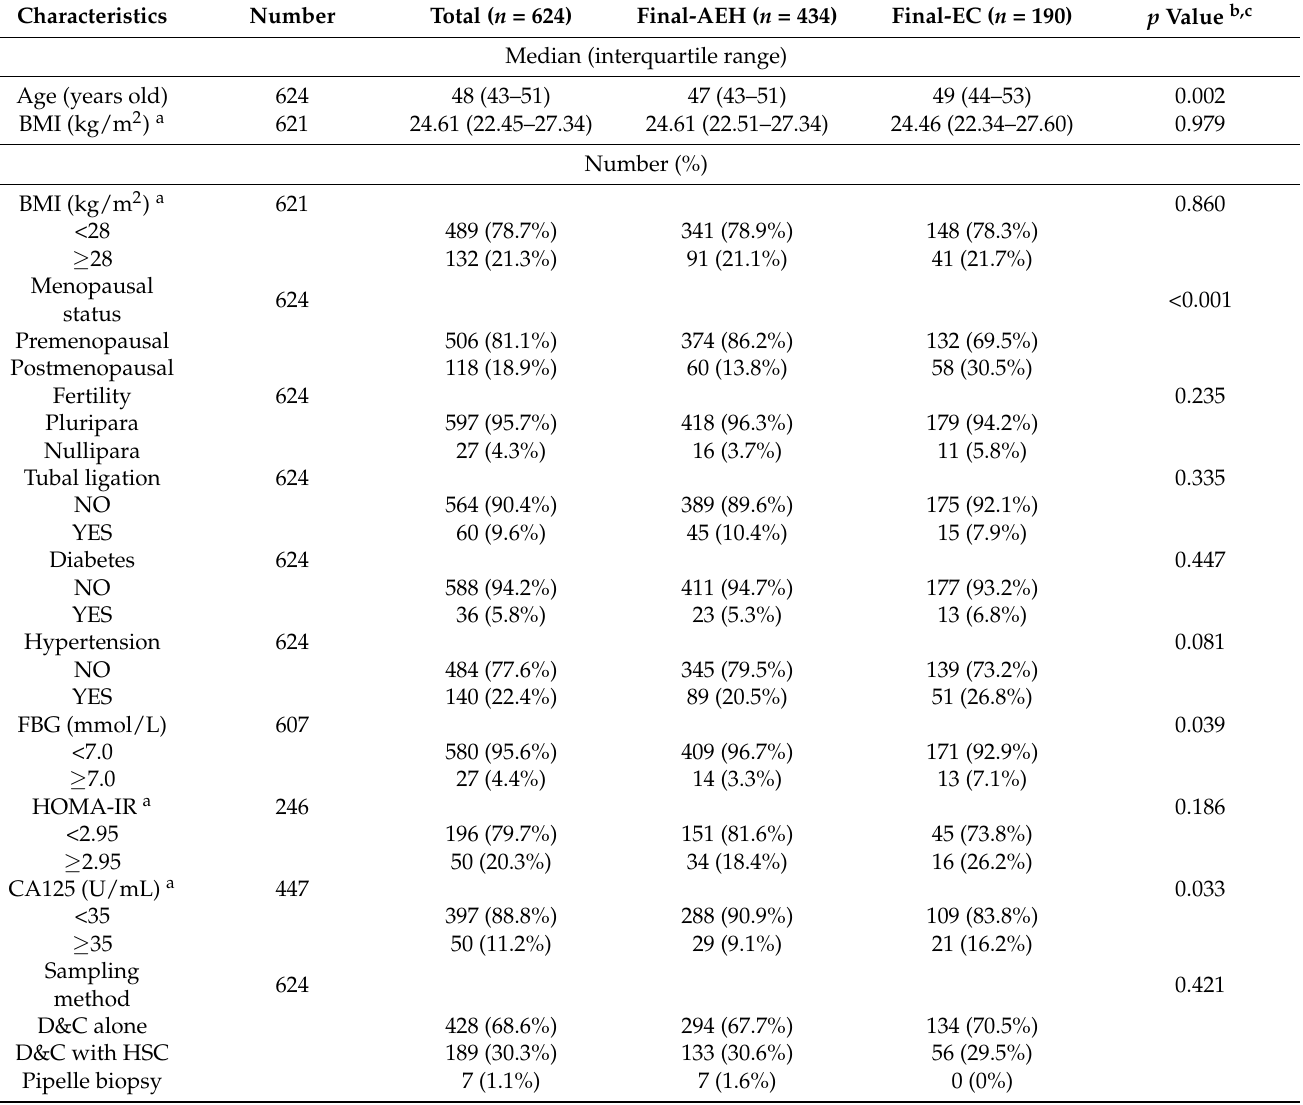
Table 1. Clinical characteristics of patients diagnosed with AEH and EC by final